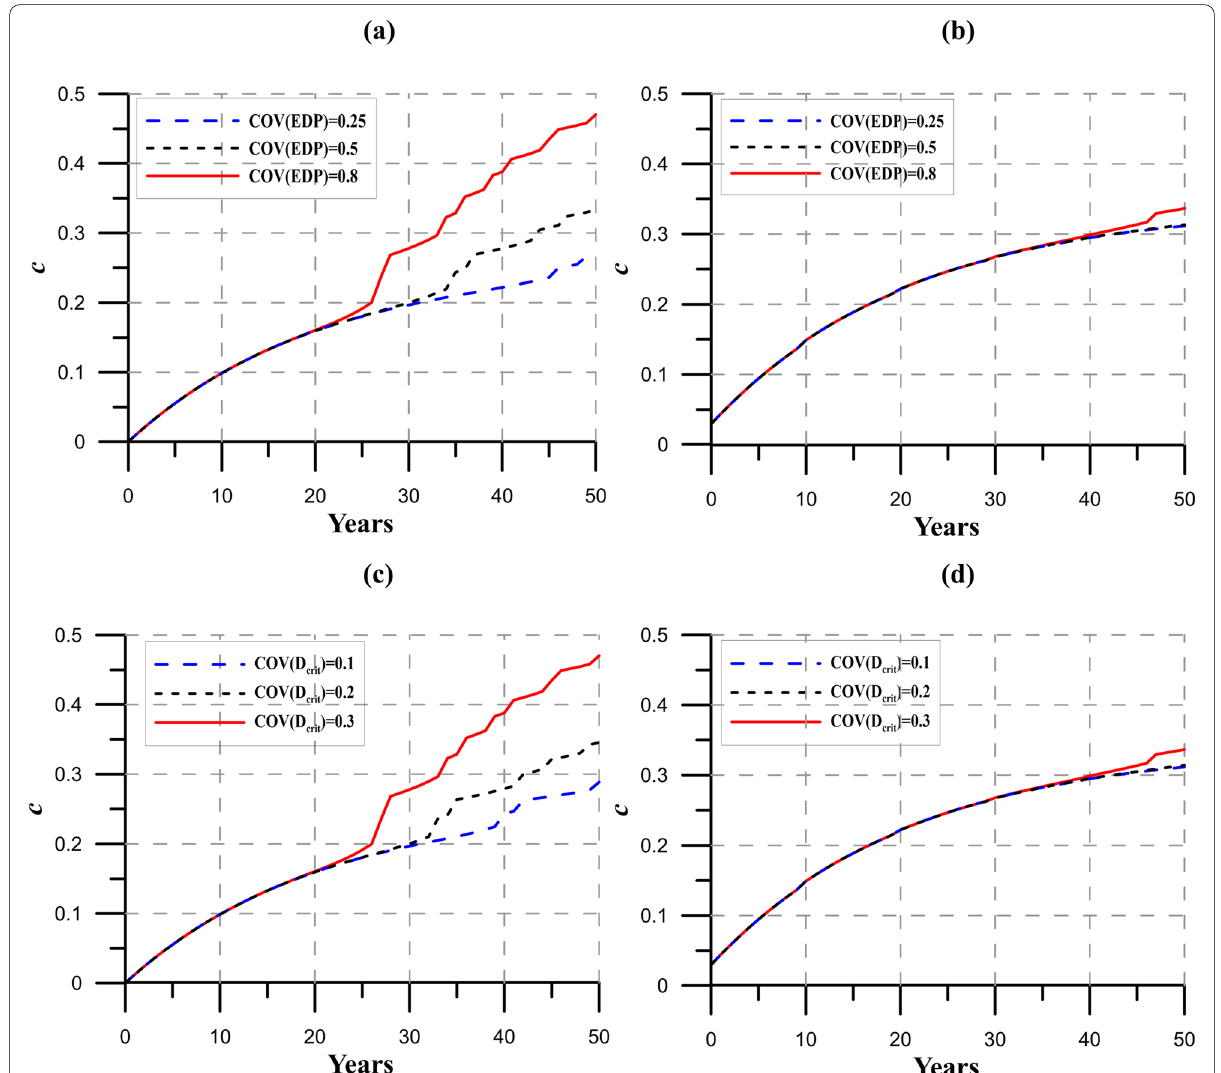
Fig. 8 Expected normalized costs over the bridge’s lifetime for different values of COV of EDP ( a - b ) and D crit ( c - d